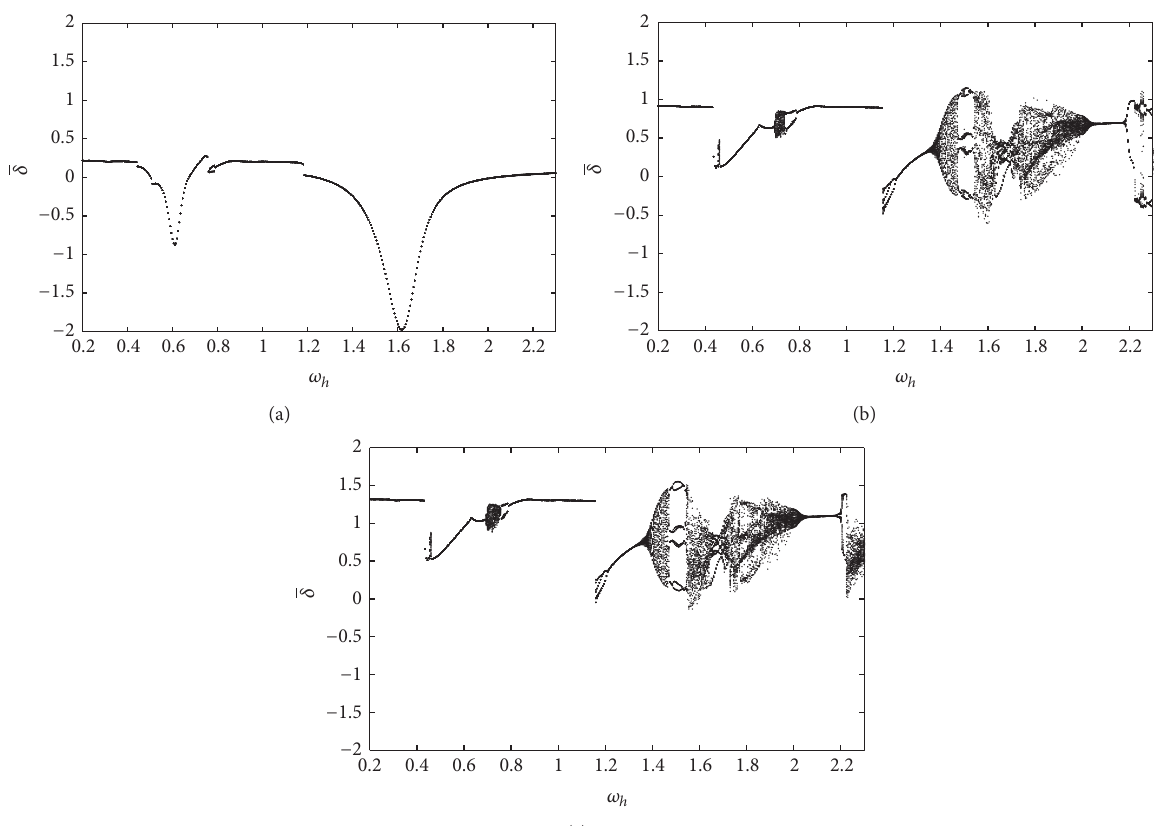
Figure 11: Bifurcation diagrams using 𝑏 as control parameter: (a) 𝑏 = 10 𝜇 m; (b) 𝑏 = 80 𝜇 m; (c) 𝑏 = 120 𝜇 m.